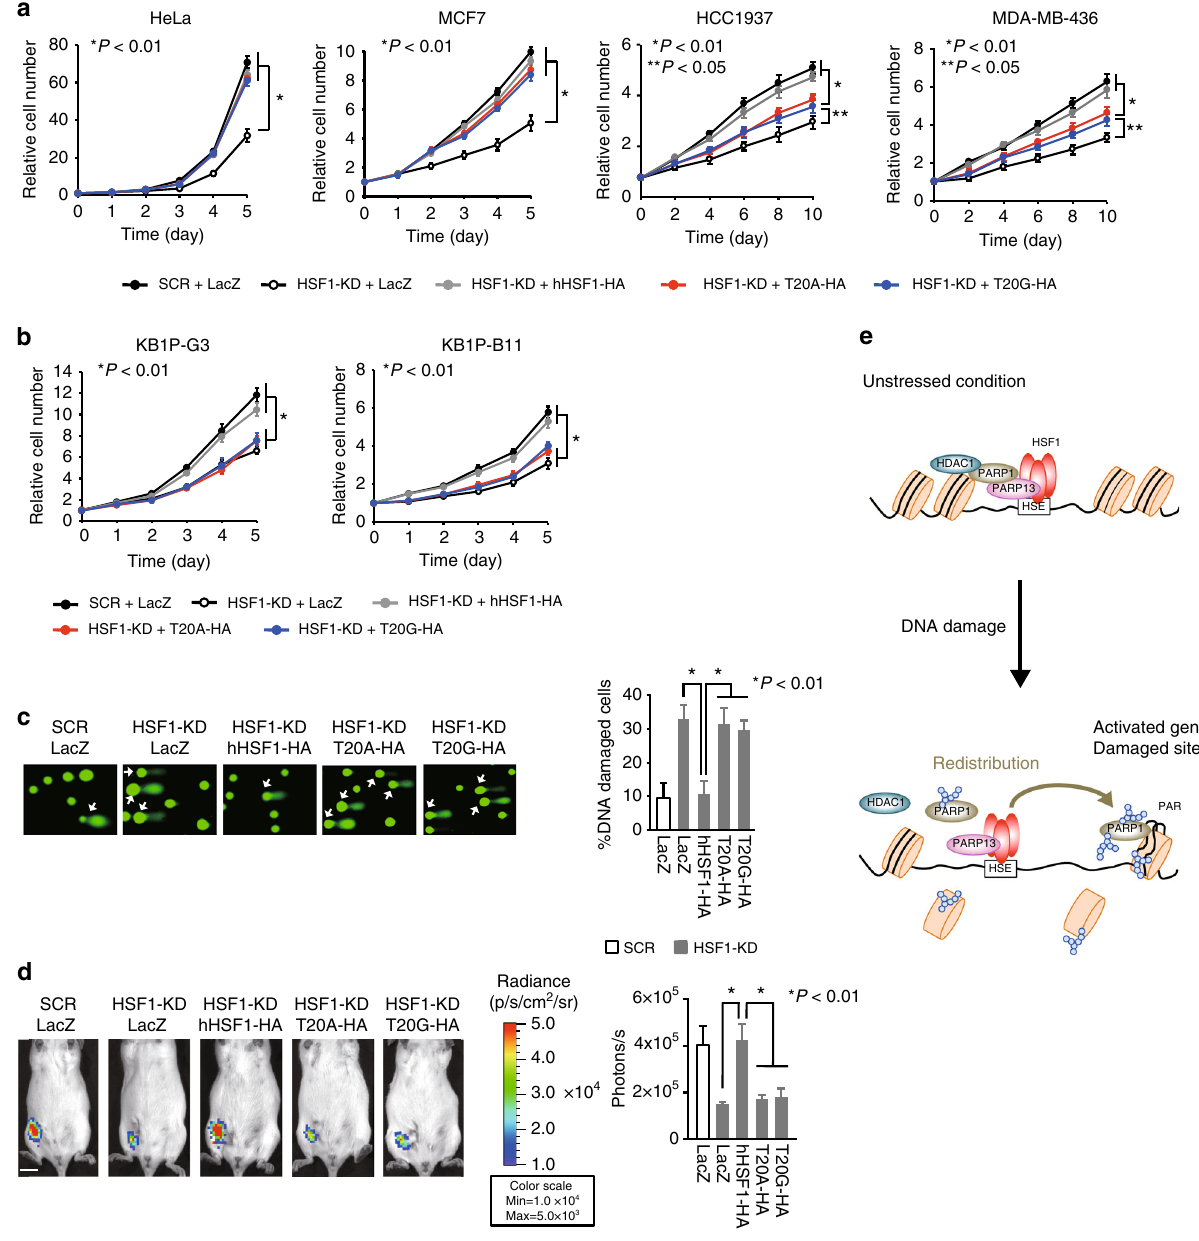
Fig. 7 HSF1 – PARP13 – PARP1 protects cells from genotoxic stress. a Proliferation of human HeLa and three mammary tumor cells expressing hHSF1-T20A or hHSF1-T20G. Endogenous HSF1 was replaced with β -galactosidase (LacZ), hHSF1-HA, or its interaction mutants. Relative cell numbers at each time point are shown ( n = 3). Mean ± s.d. is shown. Asterisks indicate P < 0.01 or 0.05 by ANOVA. b Proliferation of mouse KB1P-G3 and KB1P-B11 cells expressing hHSF1-T20A or hHSF1-T20G. Endogenous HSF1 was replaced as described in a , and relative cell numbers are shown ( n = 3). c DNA damage in KB1P-G3 cells treated as in b was measured using a neutral comet assay. Percentages of cells with DNA damage showing DNA fl uorescence in the tail (arrows) (100 cells) are shown ( n = 3). Mean ± s.d. is shown. Asterisks indicate P < 0.01 by Student ’ s t -test. d Tumor growth of KB1P-G3 cells. KB1P-G3-luc cells treated as in b were injected into the fourth left mammary fat pad of FBV/N mice, and tumor growth was evaluated by bioluminescence imaging after 4 weeks. Scale bar, 1 cm. Luciferase quanti fi cation is shown as photons per second ( n = 5). Mean ± s.d. is shown. Asterisks indicate P < 0.01 by Student ’ s t -test. e Schematic representation of the HSF1 – PARP13 – PARP1 ternary